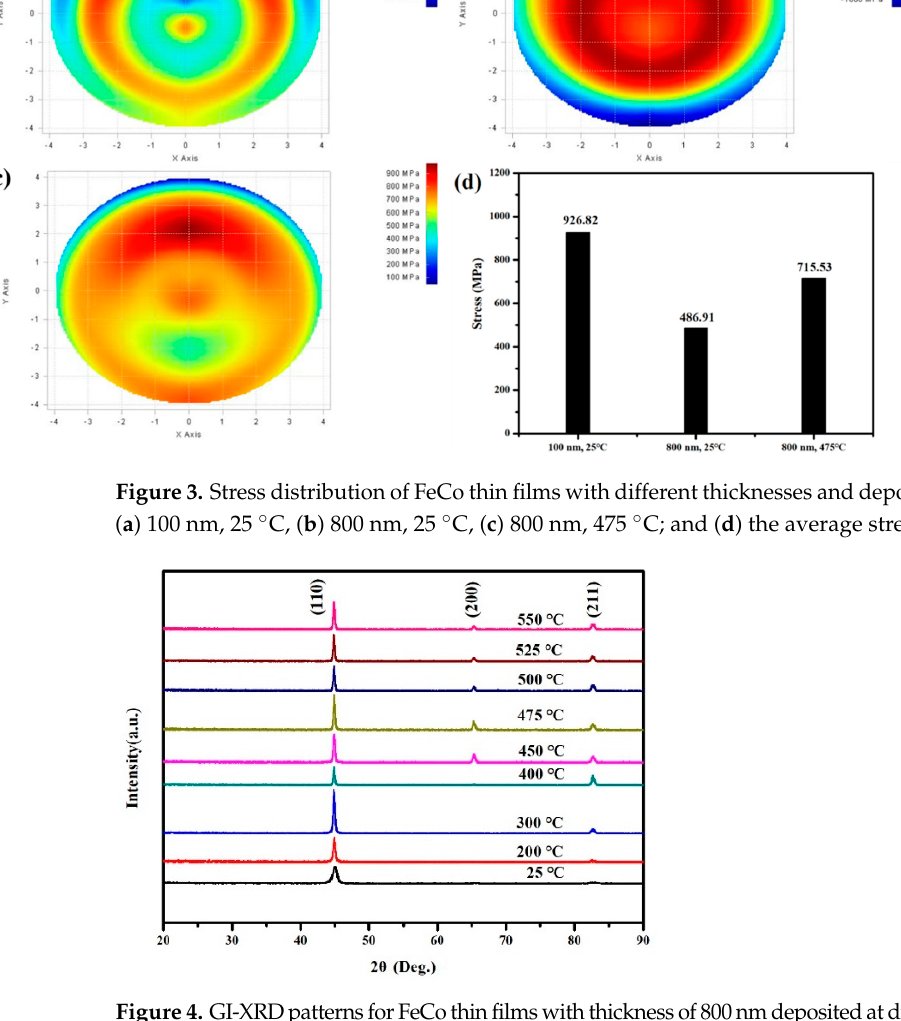
Figure 3. Stress distribution of FeCo thin films with different thicknesses and deposition tempera- tures: ( a ) 100 nm, 25 °C, ( b ) 800 nm, 25 °C, ( c ) 800 nm, 475 °C; and ( d ) the average stress.